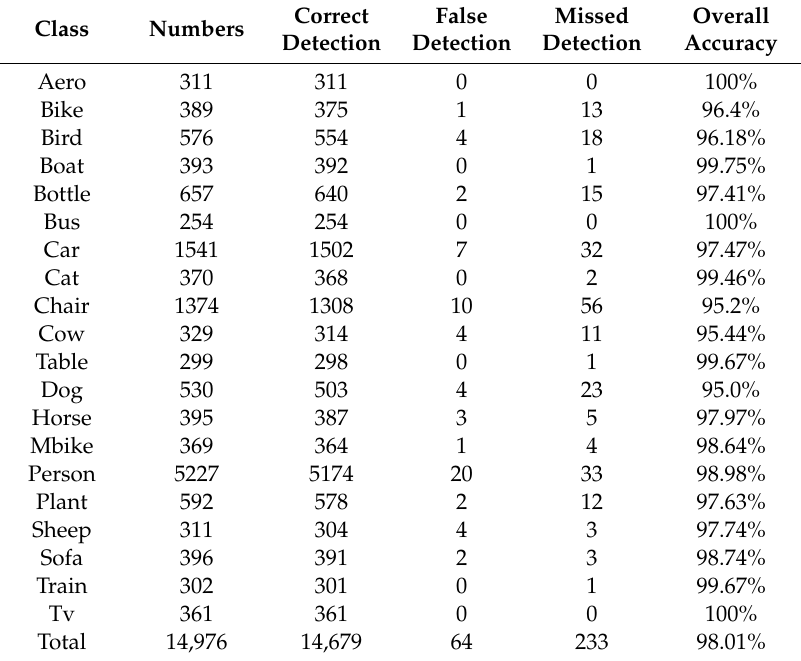
Table 5. Experiment results of the PASCAL VOC test